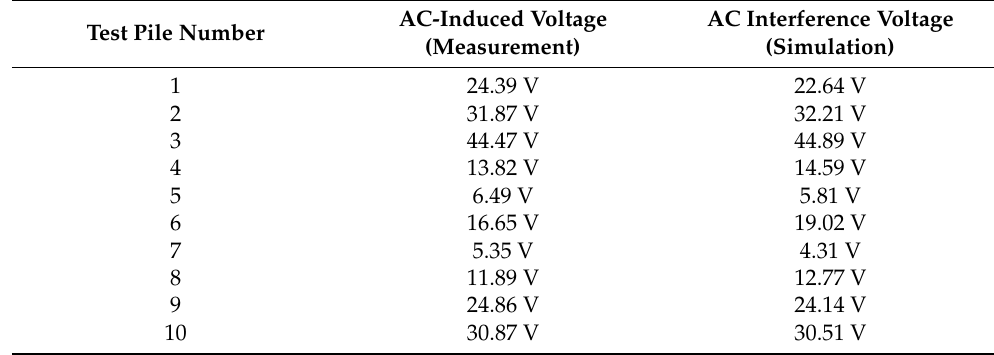
Table 3. Actual measured AC-induced voltage values versus simulated calculated AC-induced voltage